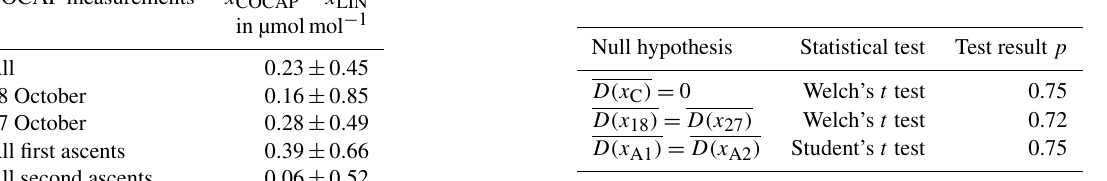
Table 4. Statistical tests for bias. Here x denotes measurements by COCAP and the index defines a subset: “A” for all measurements, “18” and “27” for 18 and 27 October, respectively, and “A1” and “A2” for first and second ascent, respectively. D(x) represents the difference between x and the corresponding measurements by LIN. An overline denotes the arithmetic